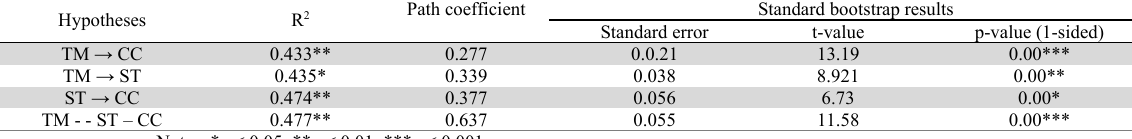
The results of the model using PLS bootstrapping procedures